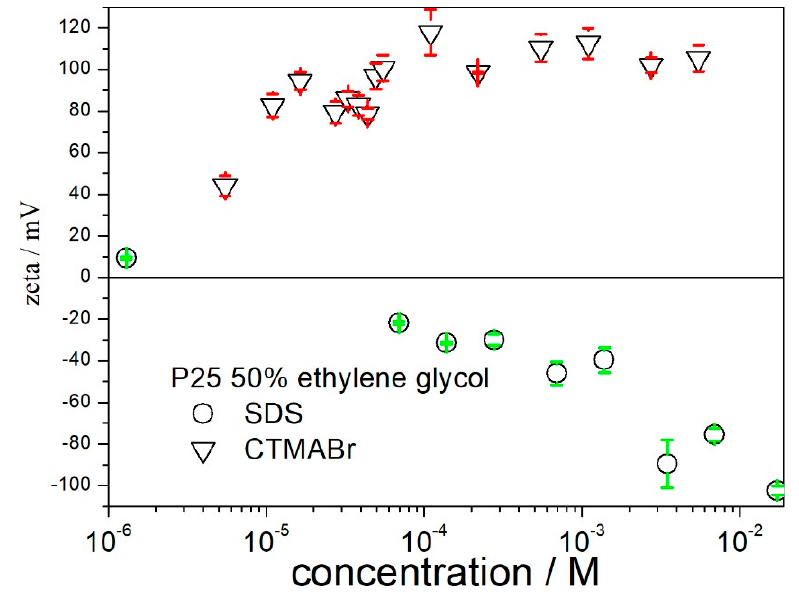
Figure 3. The effect of ionic surfactants on the zeta potential of titania in 50% EG.